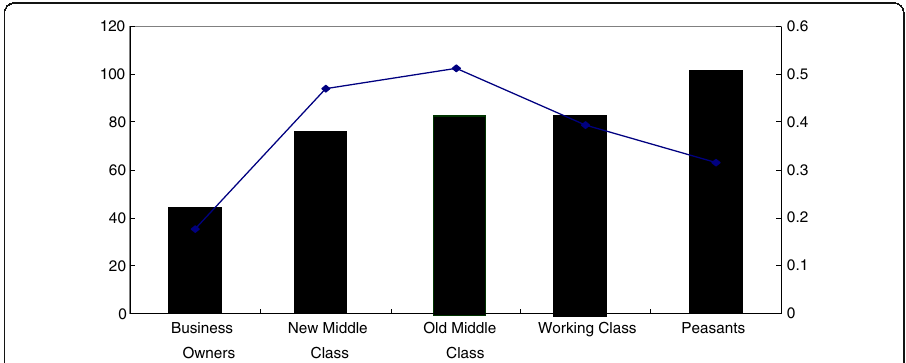
Fig. 1 Average consumption tendency and marginal consumption tendency of each class (curve represents marginal consumption